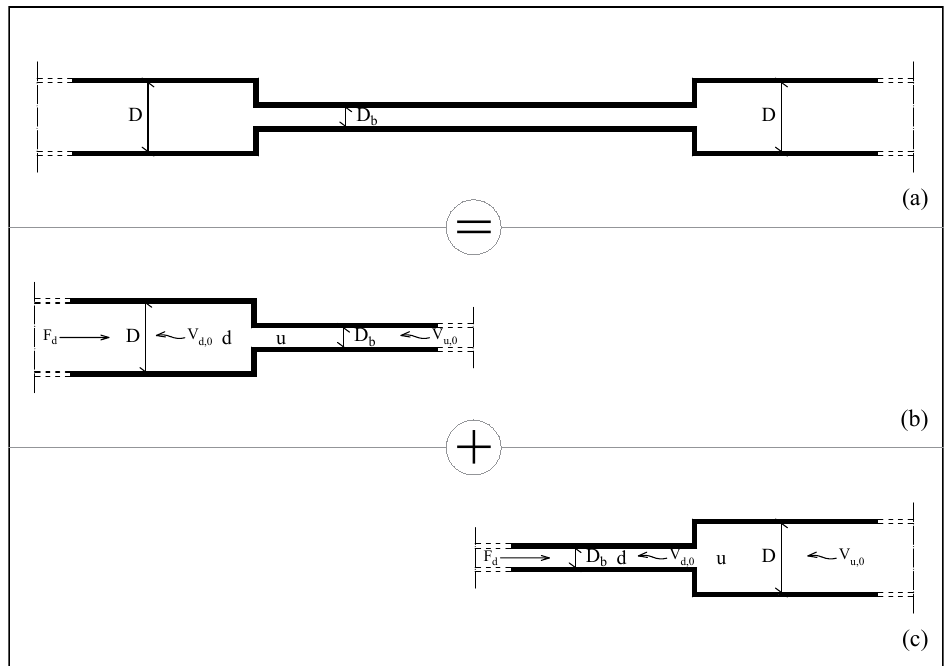
Figure 3. Sketch of extended partial blockage: ( a ) small-bore pipe (SBP), as an ideal sum of ( b ) diame- ter reduction (shrinkage) and ( c ) diameter increase